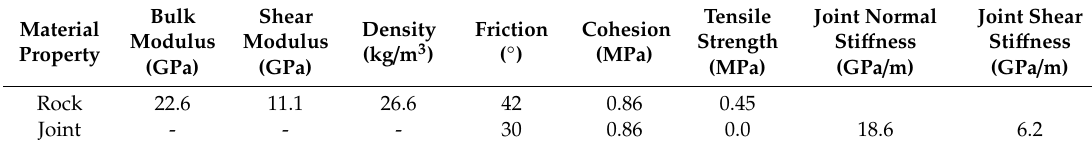
Figure 8. Simplification numerical calculation model based on discrete element. ( a ) The karst cavity diameter is smaller than tunnel; ( b ) The karst cavity diameter is equal to tunnel ( c ) The karst cavity diameter is larger than tunnel. Table 1. Strength and seepage parameters of rock in water-resistant